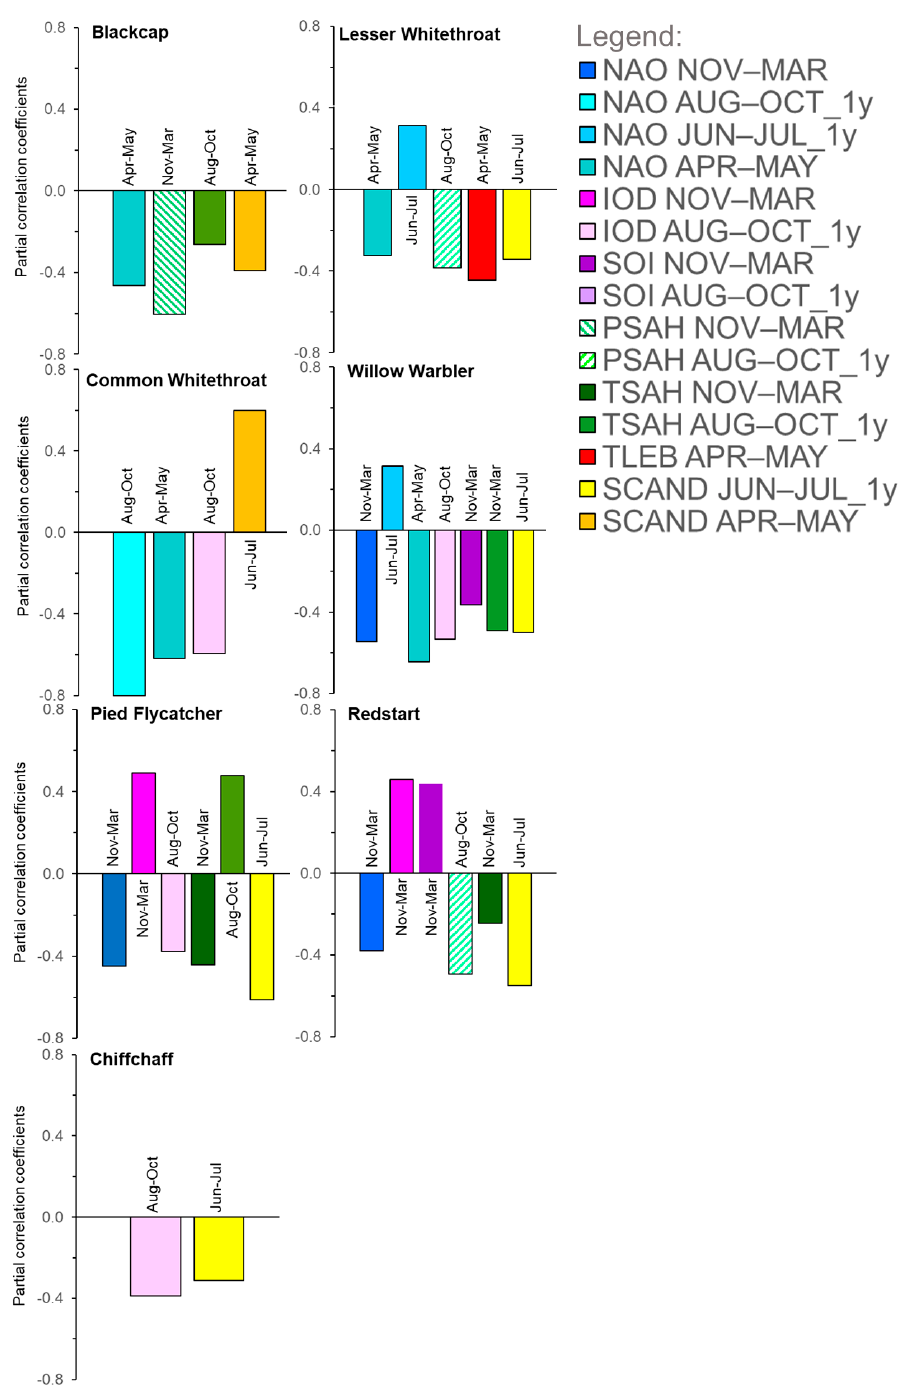
Figure 7. Partial correlation coefficients for Annual Anomaly (AA) of spring passage at Bukowo, Poland, over 1982–2021, against the climate indices selected in the best multiple regression models. The details of these models are presented in Appendix B, Tables A12–A18.